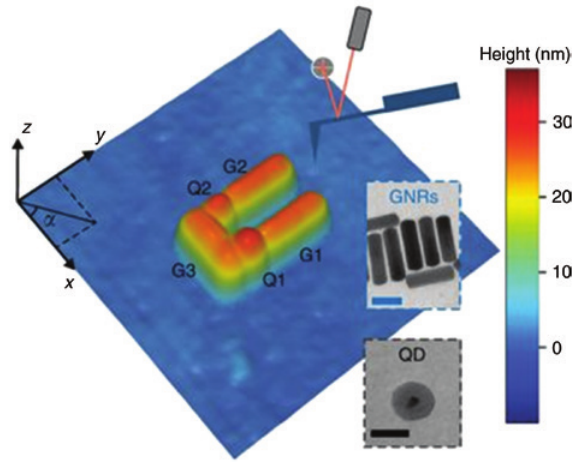
Figure 13: AFM topographical image of the U-shaped structure of three AuNRs and two silica coated QDs, illustrating the ability of nanomanipulation to make precise and complex arrangements of